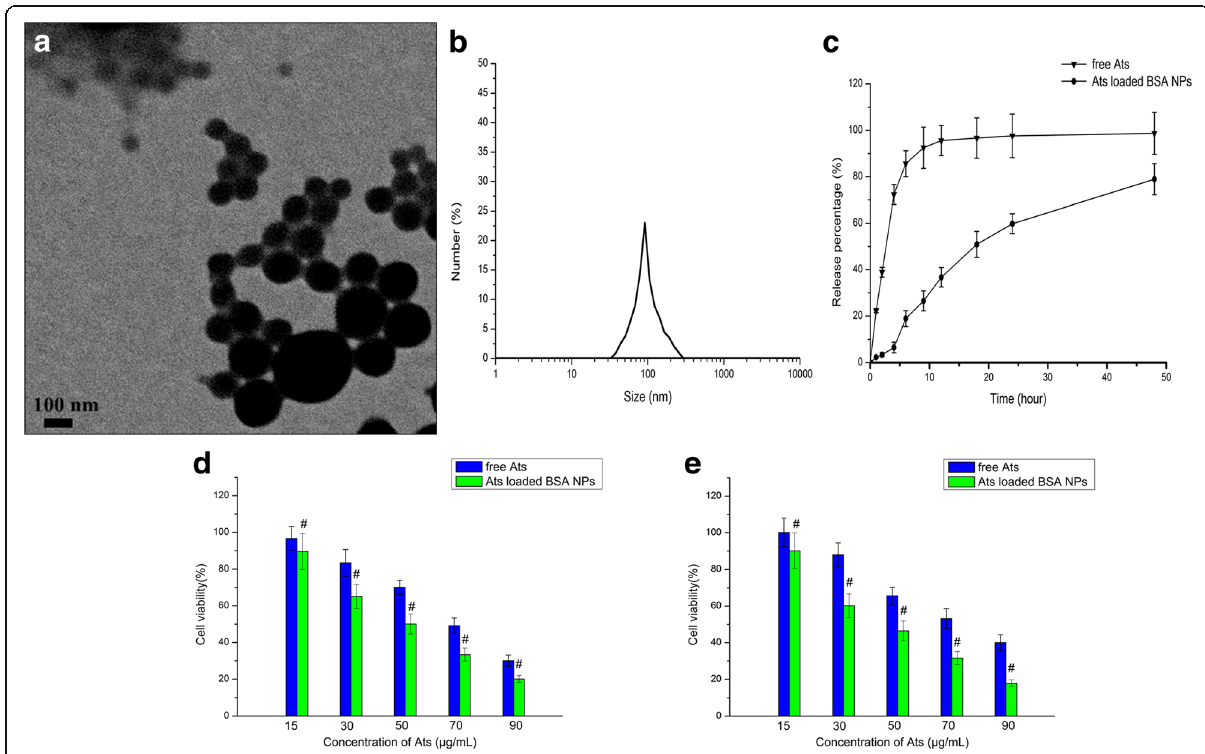
Fig. 1 Characterization of Ats-loaded BSA NPs. a TEM image of Ats-loaded BSA NPs. b Dynamic light scattering (DLS) analysis of the obtained Ats-loaded BSA NPs. c The in vitro release profile of Ats-loaded BSA NPs in phosphate-buffered saline with a pH of 7.4 at 37 °C for 48 h. Viability of SMMC-7721 cells ( d ) and Plc cells ( e ) following incubation with different amounts of free Ats and Ats-loaded BSA NPs for 24 h. The data are presented as the mean ± SD ( n = 3). # P < 0.05 versus the corresponding free